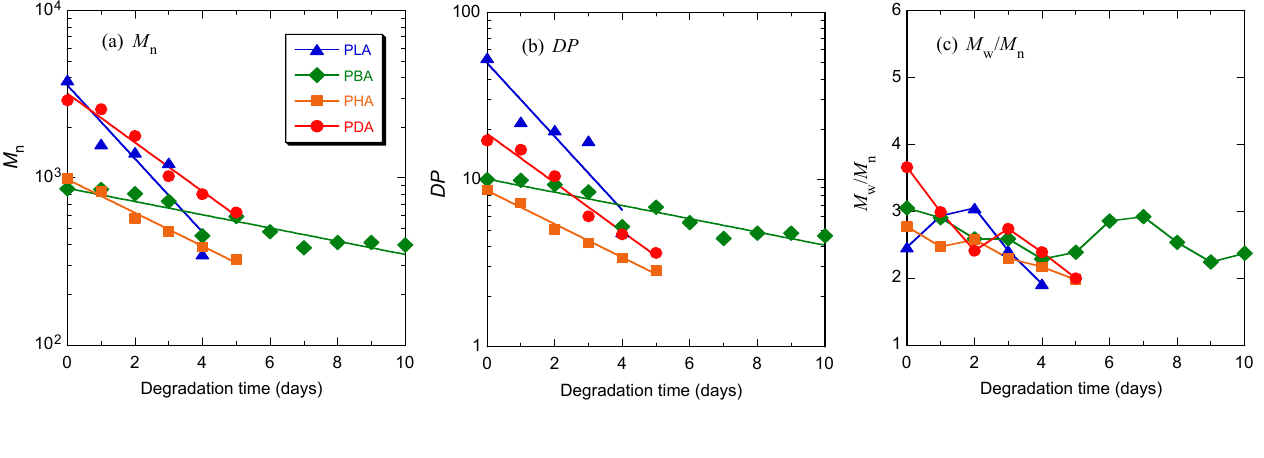
Figure 6. M ( a ), DP estimated from M n ( c ) of PLA, PBA, PHA, and PDA, during hydrolytic degradation at 80 °C, as a function of degradation time.